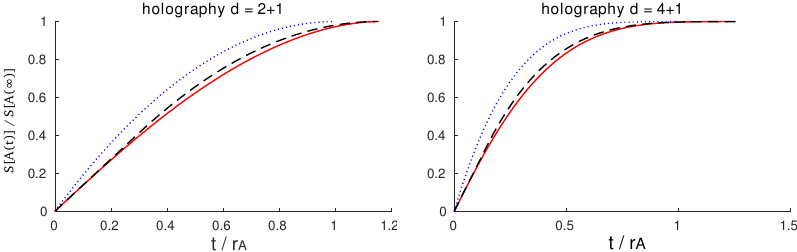
Figure 2 . The bound (3.3) for v E < v LC (left) where only the v E constraint plays a role, v LC d (cid:0) 1 v E < v LC (middle) where both are important, and v E = v LC (right) where only the v LC constraint is relevant. In the middle plot the change of color indicates the position of t 0 de(cid:12)ned in (3.3).